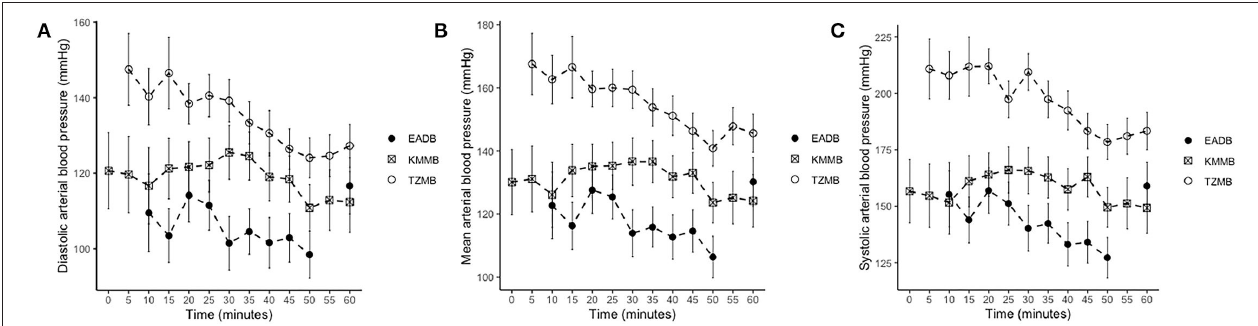
FIGURE 2 | Illustration of invasive blood pressure (IBP) over time. Values of each timepoint are the means for treatment group 1 (KMMB), treatment group 2 (TZMB) and the control group (EADB) ± standard error (error bars). (A) Comparison of systolic arterial IBP between TG 1, TG 2 and control group. (B) Comparison of mean arterial IBP between TG 1, TG 2 and control group. (C) Comparison of diastolic arterial IBP between TG 1, TG 2 and control group.